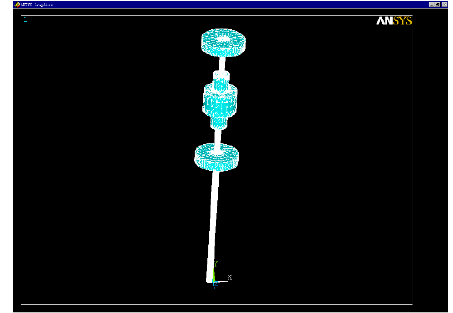
Figure 4. Partial structure of the blowdown pipe.